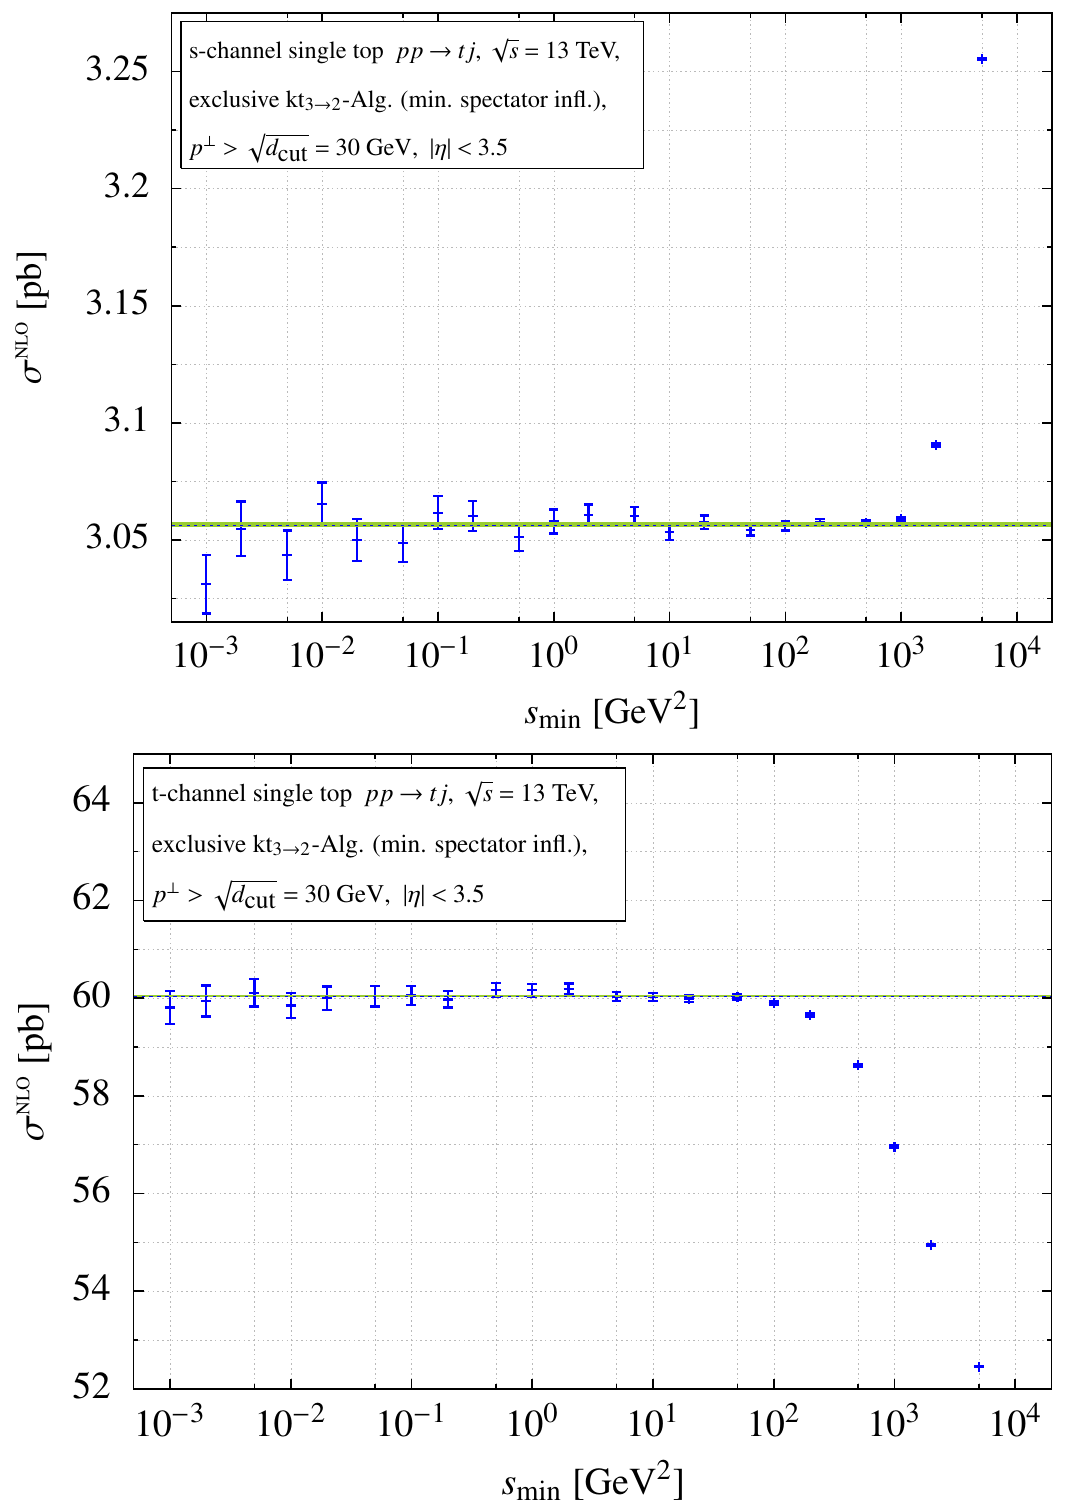
Figure 1 . Fiducial NLO cross section for the s -channel (upper plot) and t -channel (lower plot) production of a top-tagged and a light jet as a function of the Phase Space Slicing parameter s min .